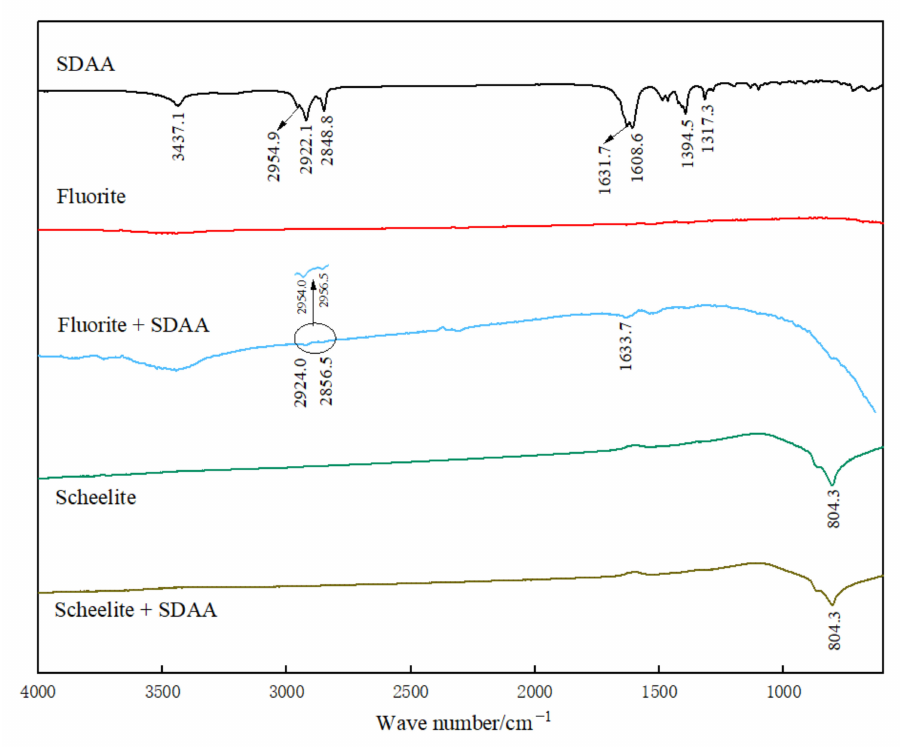
Figure 7. FTIR spectra of SDAA and two minerals before and after the treatment of